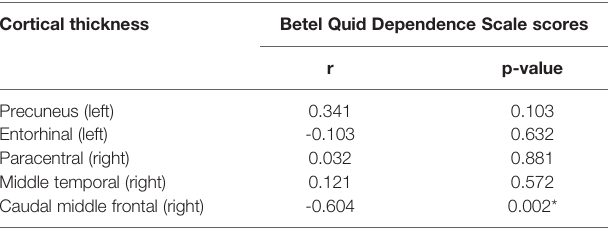
TABLE 3 | Pearson ’ s correlation coef fi cients between the mean value of cortical thickness (CT) and betel quid dependence scale (BQDS) scores in betel quid dependent individuals (n=24, * p <